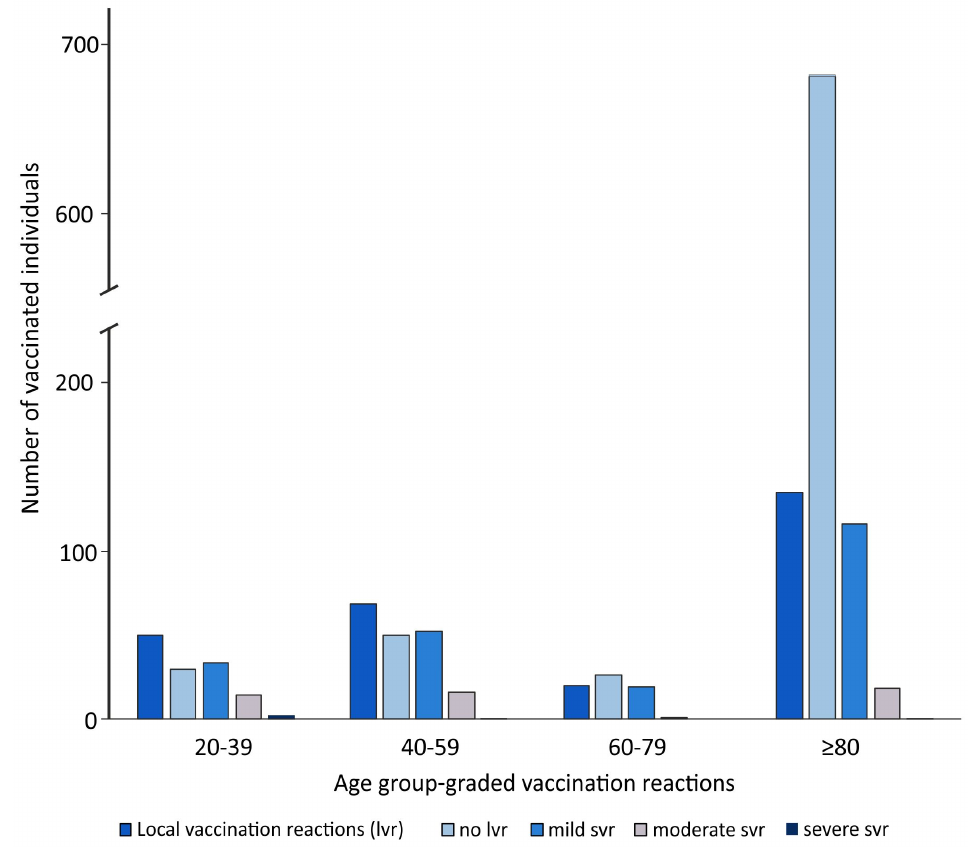
Figure 1. Age group-graded local vaccination reactions.The 20–39-year-old individuals had no vaccination reactions in 30% (24/80), the 40–59-year-olds in 36% (43/119), the 60–80-year-olds in 52% (24/46) and those over 80 years in 77% (629/820) ( p < 0.001) (Table 3). Table 3. Age-group-graded vaccination reactions.